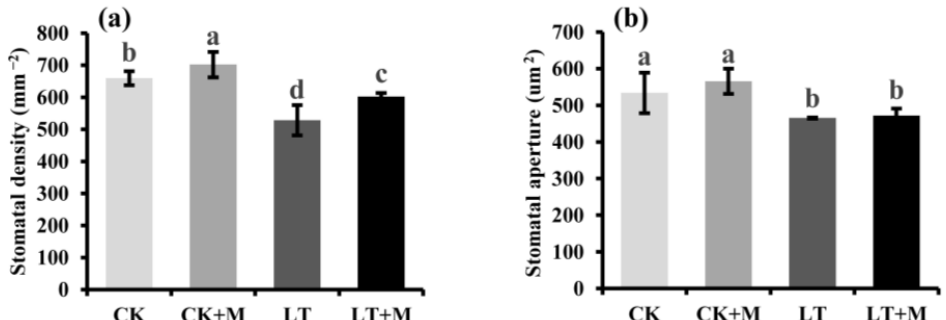
Figure 2. Effects of wood vinegar on the stomatal density and aperture of rapeseed seedlings stomatal density ( a ) and stomatal aperture ( b ) under low-temperature stress. Error bars are ± SE (n = 6). According to the LSD test, the lowercase letters in the figure indicate significant differences ( p < 0.05). CK, normal temperature; CK + M, normal temperature + wood vinegar; LT, low temperature; LT + M, low temperature + wood vinegar.